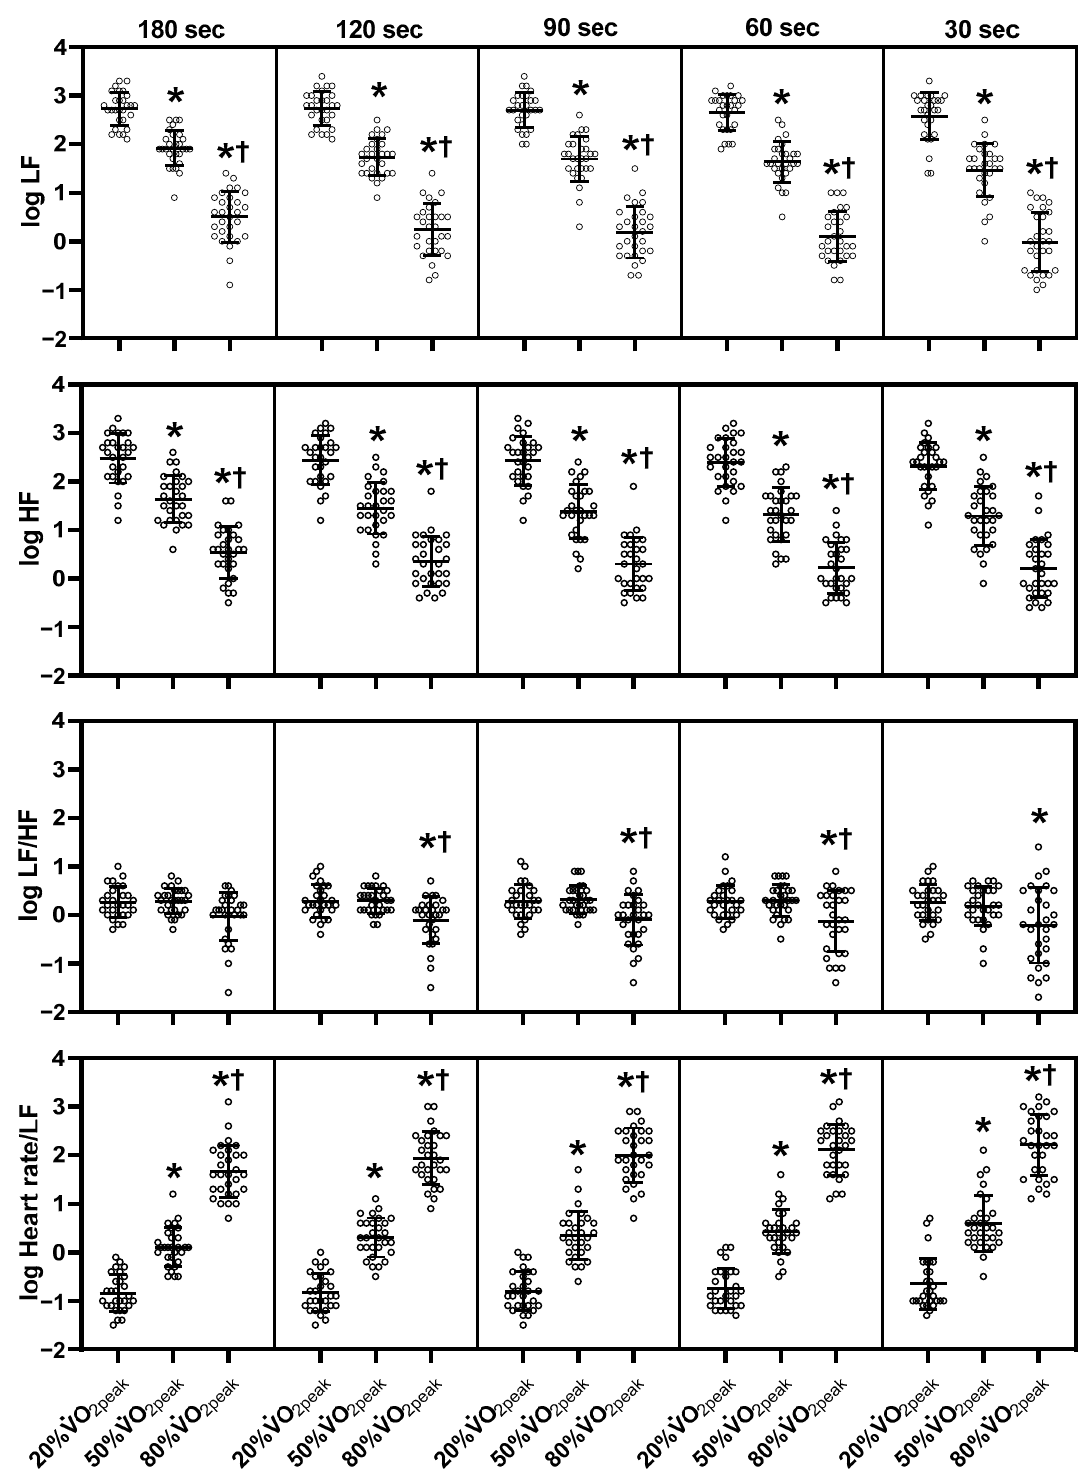
Figure 3. Changes of each ultra-short-term segment of frequency-domain HRV parameters dur- ing exercise. HF, high-frequency power; LF, low-frequency power; log, logarithmic; sec, seconds; . VO 2peak , peak oxygen uptake. The middle line indicates the mean value. The top and bottom lines indicate the SD. The white plots indicate the individual data of participants. Note that there is missing data at 20% VO 2peak (see the Materials and Methods section). *, p < 0.05 vs. 20% †, p < 0.05 vs. 50% VO 2peak